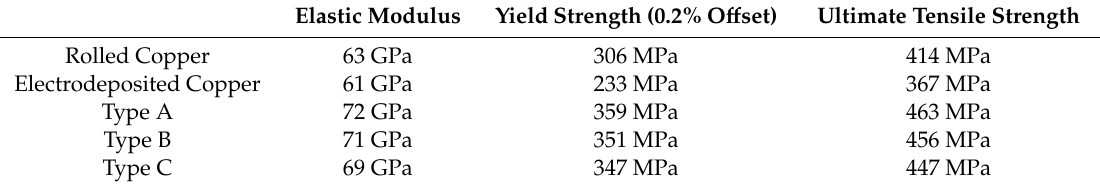
Table 1. The result of mechanical properties rolled and electrodeposited copper and depending